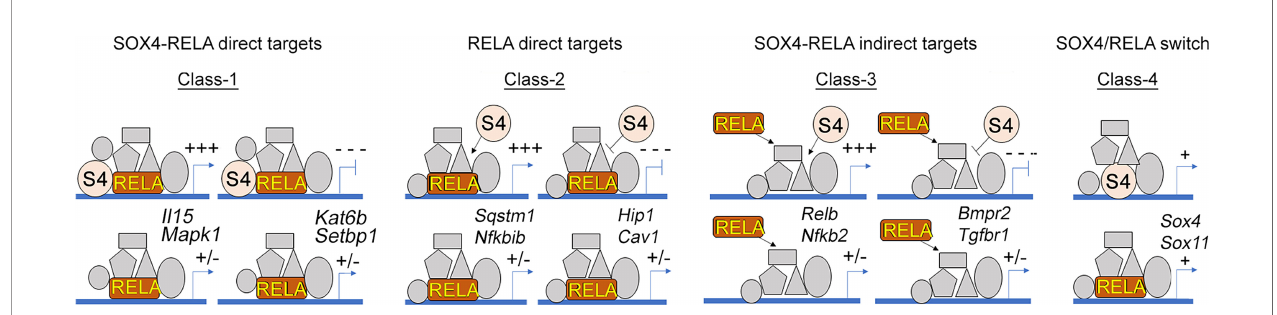
FIGURE 4 | Multimodal regulation of gene expression by RELA and SOX4. Illustration of the 4 different classes of SOXC-dependent and TNF-responsive genes and their predicted responses upon SoxC-knockout are indicated. Two representative examples of each class are indicated.